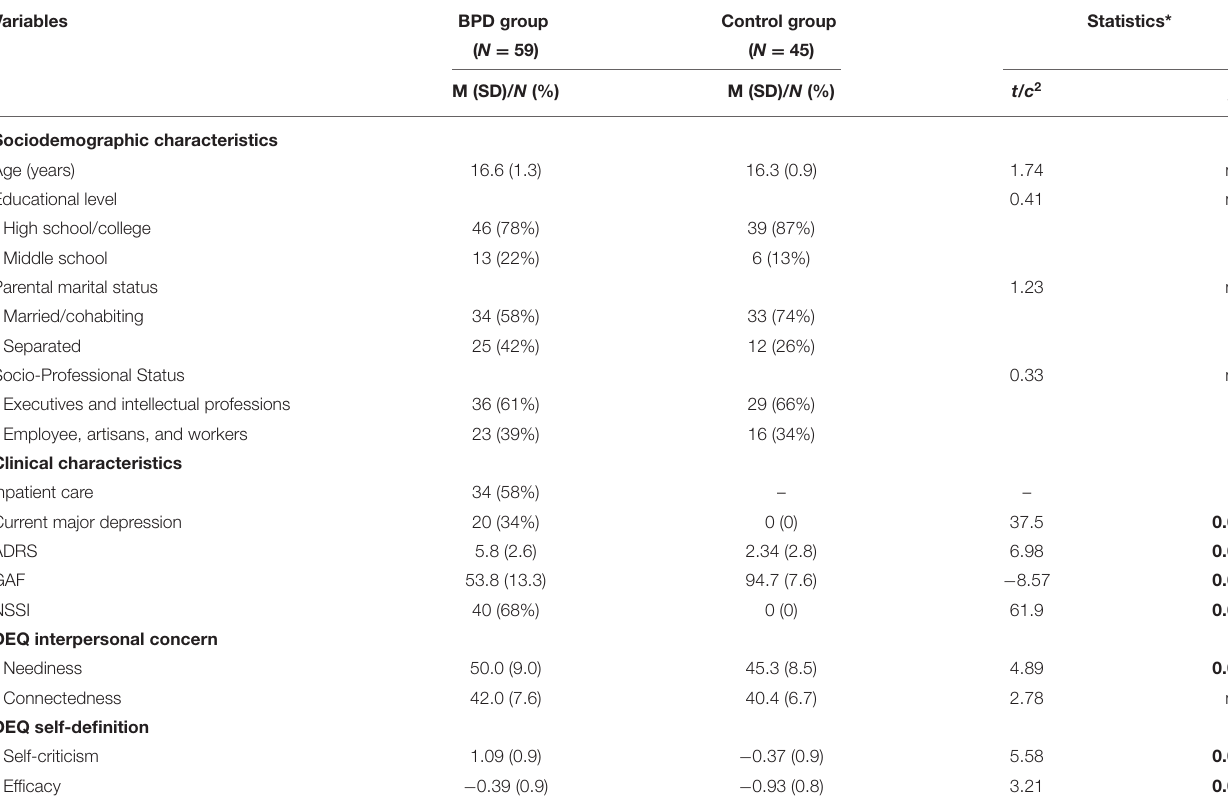
TABLE 1 | Sociodemographic and clinical characteristics of BPD and control groups.